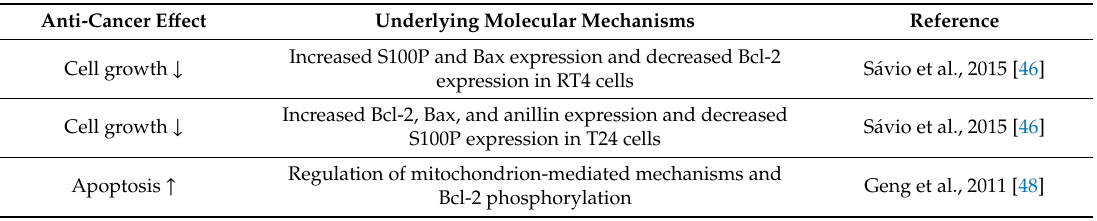
Table 1. In vitro molecular mechanism of the anti-cancer e ff ects of allyl